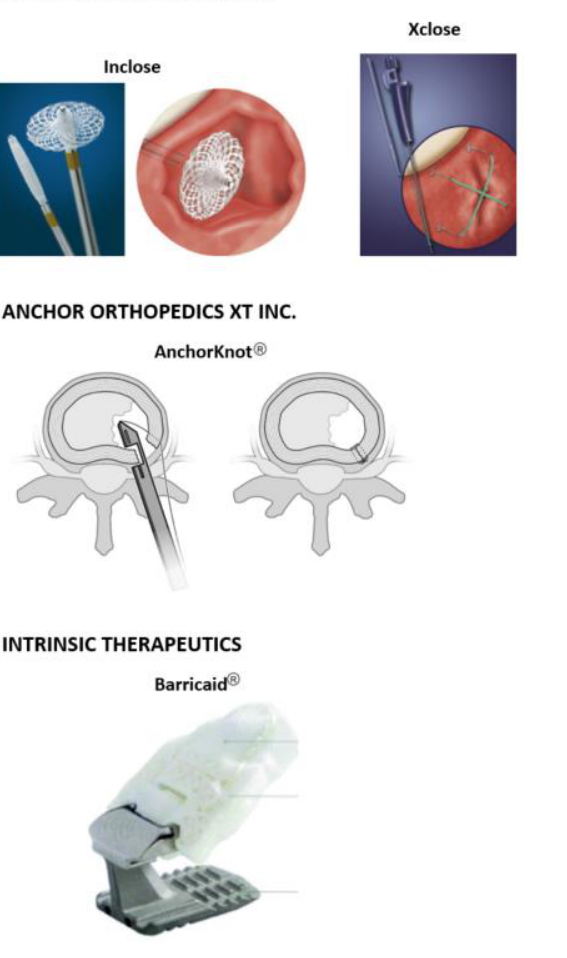
Figure 2. Commercial mechanical annular closure devices. ( Top ) Inclose Surgical Mesh System and the Xclose Tissue Repair System (Anulex Technologies, Inc. Minnetonka, MN, USA) [27]. ( Middle ) The AnchorKnot ® suture-passing device (Anchor Orthopedics XT Inc., Mississauga, ON, USA [31]. ( Bottom ) The Barricaid ® Annular Closure Device (Intrinsic Therapeutics, Woburn, MA, USA) [58].